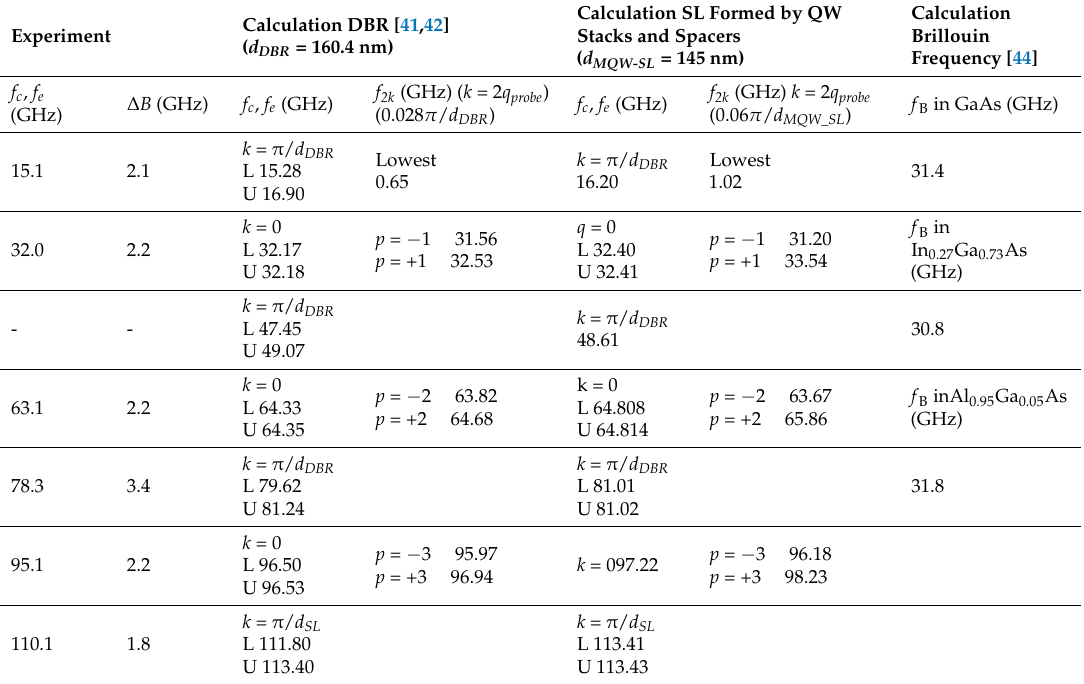
Table 4. Acoustic phonon spectrum in the low frequency